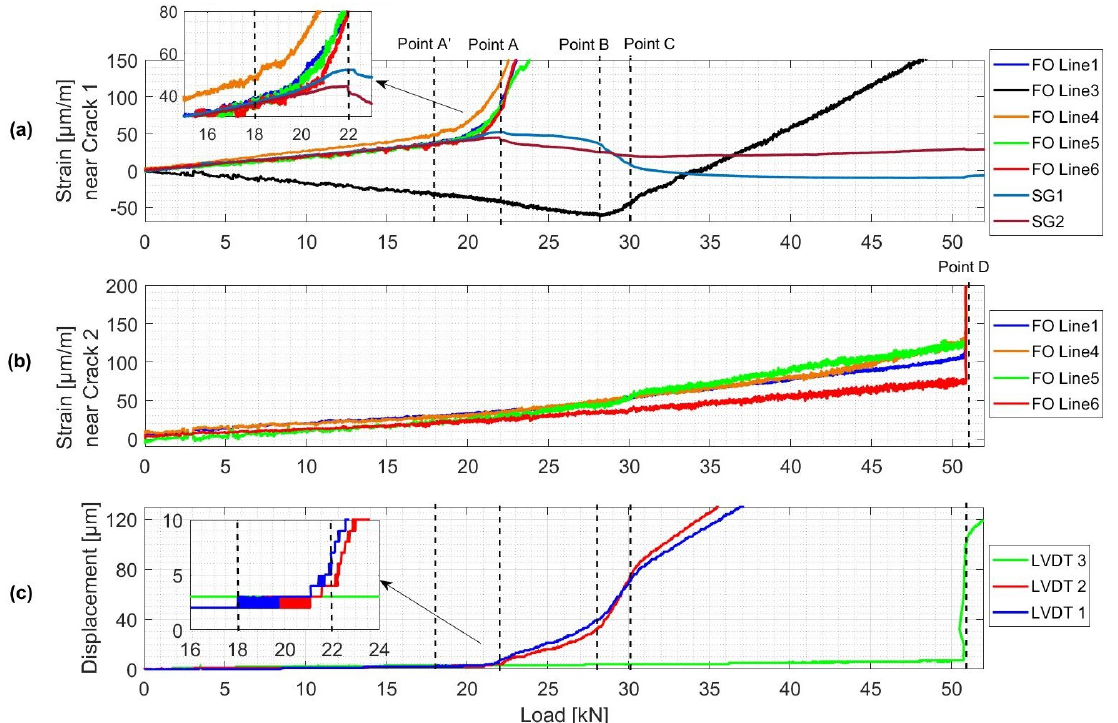
Figure 11. (a) Strain variations measured by FO lines and SG sensors near Crack 1. (b) Strain variations measured by FO lines near Crack 2. (c) Horizontal displacements measured by LVDT